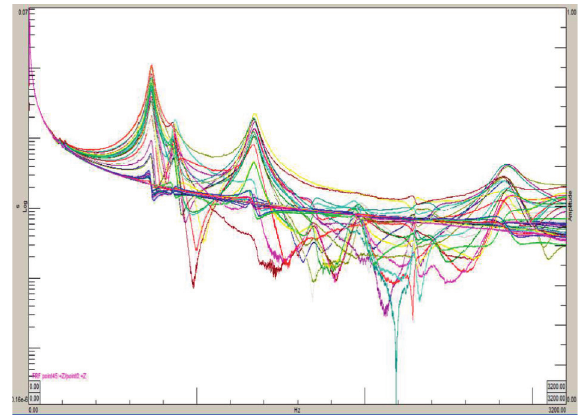
Figure 11: Experimental frequency response function base excitation vs velocity. Table 9: Experimental modal analysis: mode shapes and natural frequencies (Case